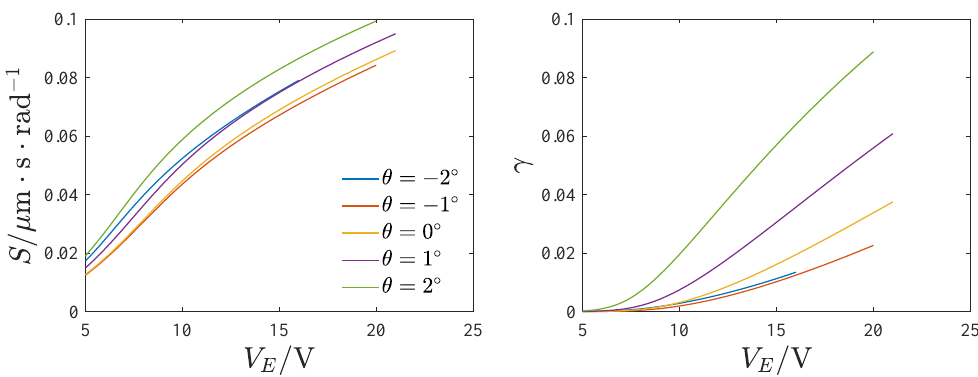
Figure 20. The influence of the voltage on the mechanical sensitivity and nonlinearity; Ω = 1.